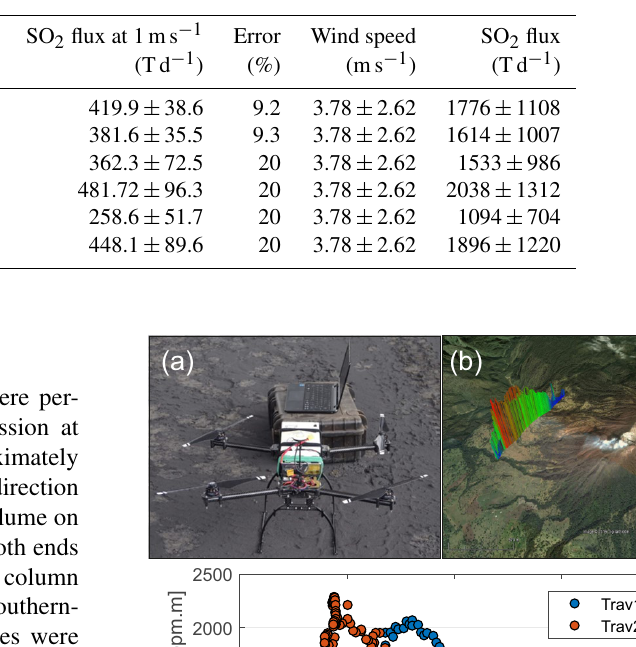
Table 5. SO 2 fluxes obtained by DROAS traverses and two stationary scanning DOAS instruments at Turrialba volcano. The average fluxes from La Silvia and La Central were derived for a 2h period in which the DROAS flights were conducted, maximum fluxes for this period as presented as well.